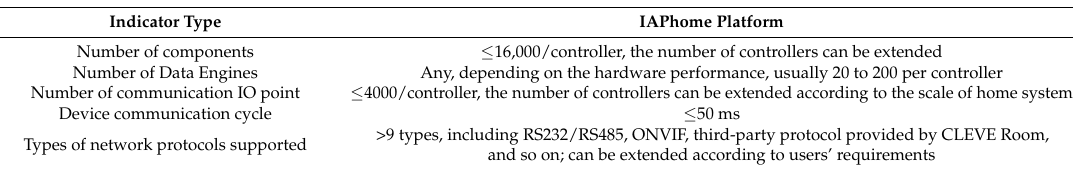
Table 3. IAPhome platform technical indicators.